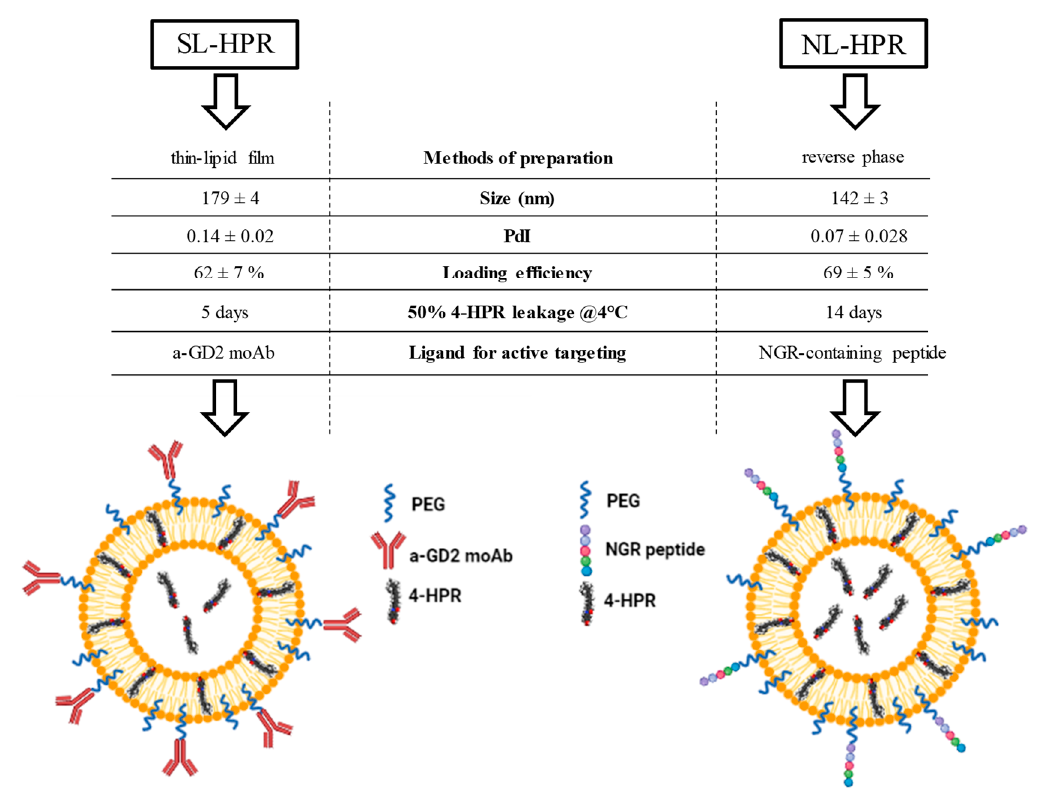
Figure 2. Comparison of tumor- ( left ) and tumor vasculature- ( right ) targeted liposomal formulations of fenretinide. PEG: polyethylene glycol; a-GD2 moAb: anti-disialoganglioside GD2 monoclonal antibody; 4-HPR: N-(4-hydroxyphenyl)retinamide (fenretinide); NGR peptide: NGR-containing peptide; SL: Stealth Liposomes; NL: NanoLiposomes.